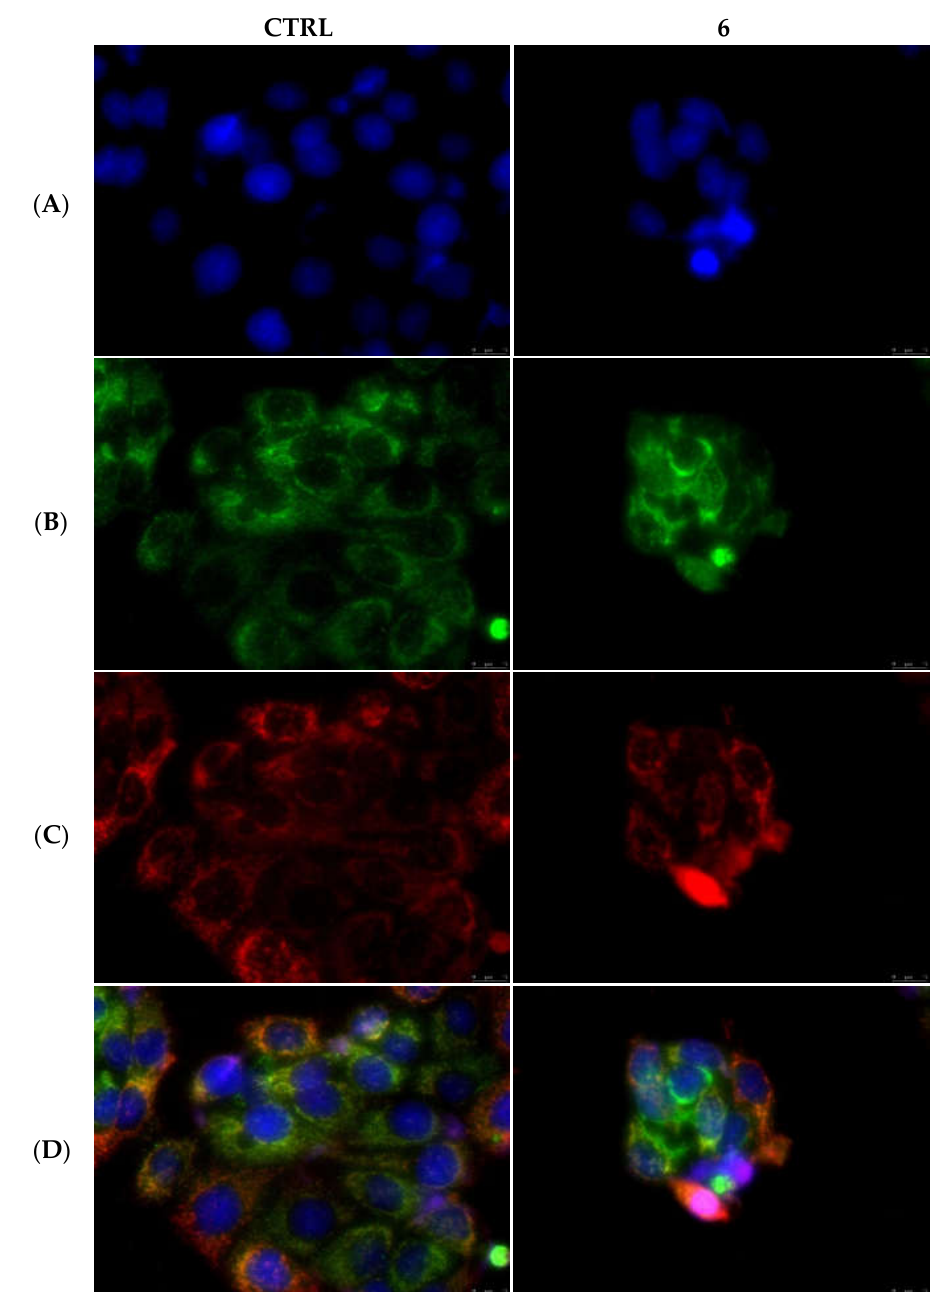
Figure 12. Mitochondria staining and cytochrome c detection in MCF-7 cells. In the CTRL cells as well as in the cells treated with compound 6 at its IC50 value for 24 h, cytochrome c is localized within mitochondria. Panels ( A ), DAPI λ ex/em = 350/460 nm; Panels ( B ), Alexa Fluor CF 488 λ ex/em = 490/515 nm; Panels ( C ), MitoTracker Deep Red FM probe λ ex/em = 644/665 nm; Panels ( D ), overlay channels. Images were acquired at 40× magnification and representative fields are shown.